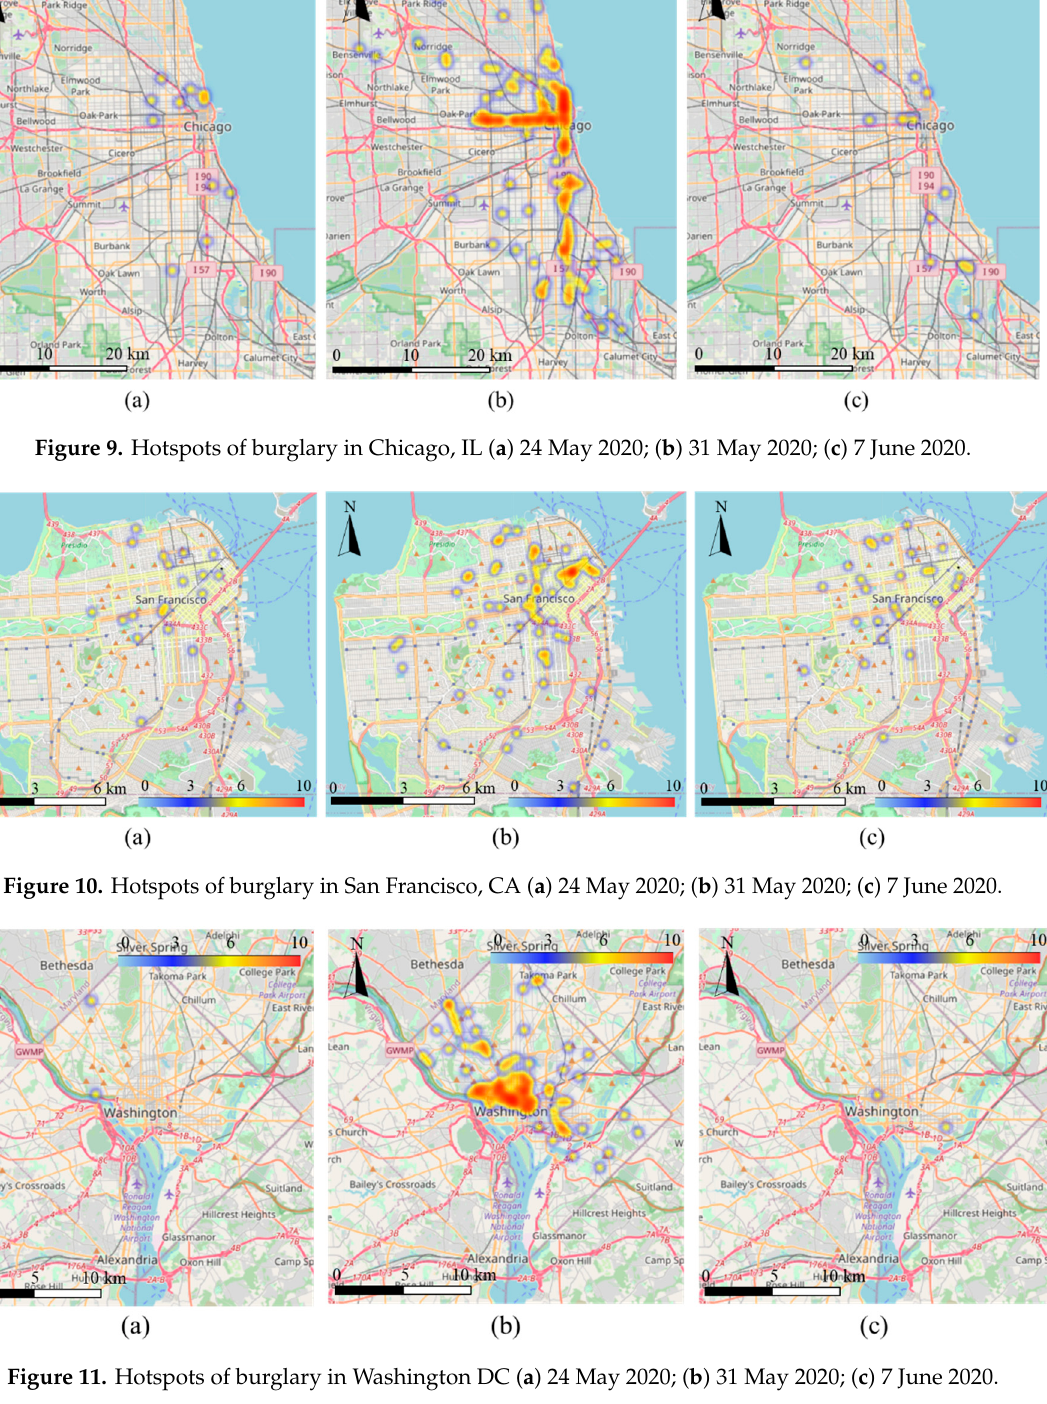
Figure 12. Hotspots of burglary in Minneapolis, MN ( a ) 21 May 2020; ( b ) 28 May 2020; ( c ) 4 June 2020 3.4. Impact of Driving Factors on Burglary during Black Lives Matter Protests 3.4.1. Changing Rate of Burglary The results of Sections 3.1 and 3.2 lead us to explore which counties/cities have changed obviously with burglary during the BLM protest. To explain the degree of effect of protests on burglary, we calculated the changing rate using Equation (2). In addition, the parameter n is 5, because burglary usually peaked and continued three to five days from the start of the early protests.